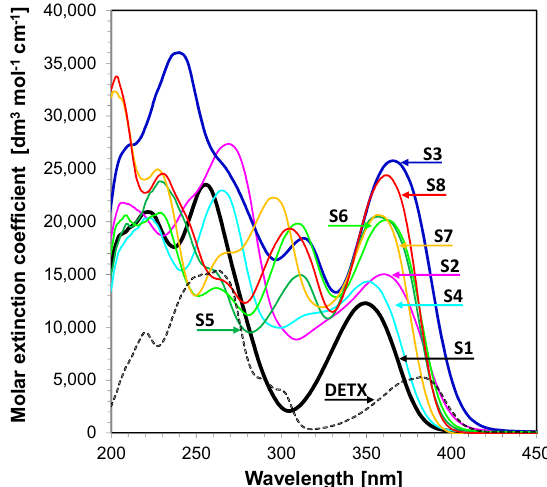
Figure 1. Ultraviolet (UV)–visible absorption spectra of the 2-amino-4,6-diphenyl-pyridine-3-carbonitrile derivatives and 2,4-diethyl-9 H -thioxanthen-9-one (DETX) in acetonitrile.